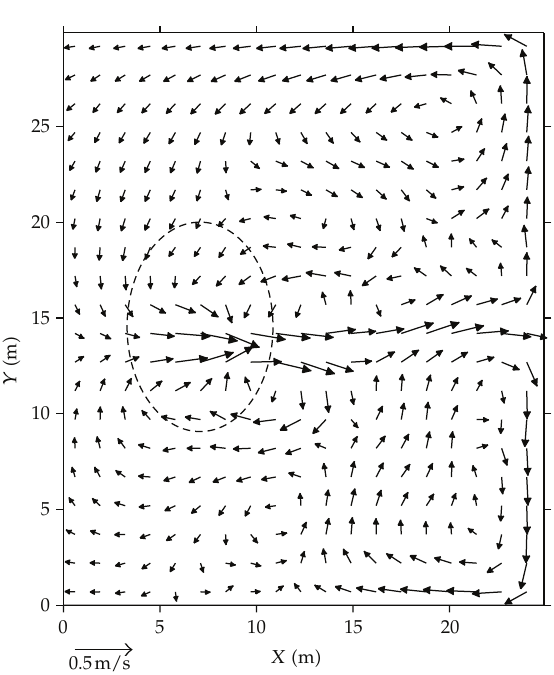
Figure 6: The horizontal distribution of the calculated current fields after the third two-way iteration.